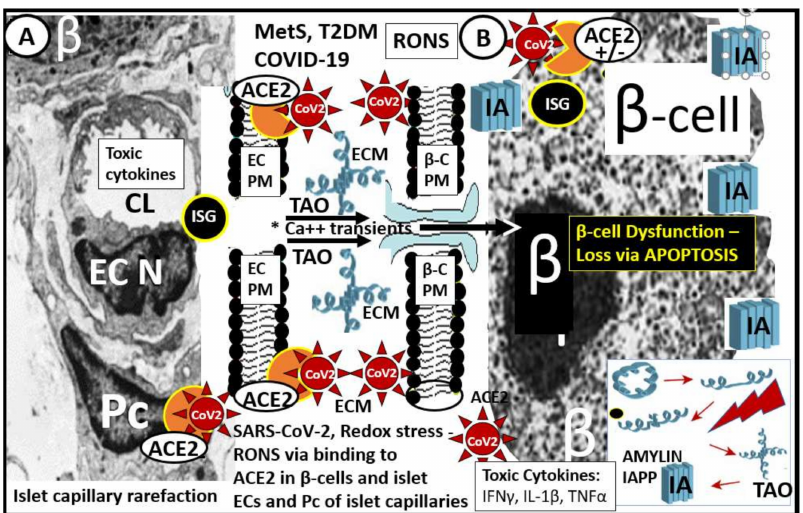
Figure 13. Pancreatic islet β -cells undergo a multiple hit injury with MetS / T2DM and COVID-19. This illustration depicts the close relationship of the islet capillaries and the β -cells with transmission electronic microscopic (TEM) images of the pancreatic islet capillary Panel ( A ) and the β -cell Panel ( B ) in those infected by SARS-CoV-2. Panel ( A ) depicts an islet capillary in close proximity to an islet β -cell (preclinical HIP rodent model) and notes that CoV-2 may bind not only to the endothelial cell ACE2 protein of capillary endothelial cells but may also bind to pericytes, since ACE2 has recently been found to bind to pericytes in the brain and myocardial capillary specimens especially if the EC glycocalyx barrier function has been damaged allowing SARS-CoV-2 to enter the subendothelial space. Panel ( B ) illustrates the small electron dense dots that are the insulin secretory granules (ISG) within the β -cell cytoplasm (preclinical HIP rodent model). Additionally, amylin undergoes unfolding and misfolding to form islet amyloid polypeptide (IAPP) (panel ( B )—lower right hand) when exposed to toxic oxidative stress—reactive oxygen and nitrogen (nitrosative stress) species (RONS). The early more intermediate-sized toxic amyloid oligomers (TAO) of amylin have a propensity to